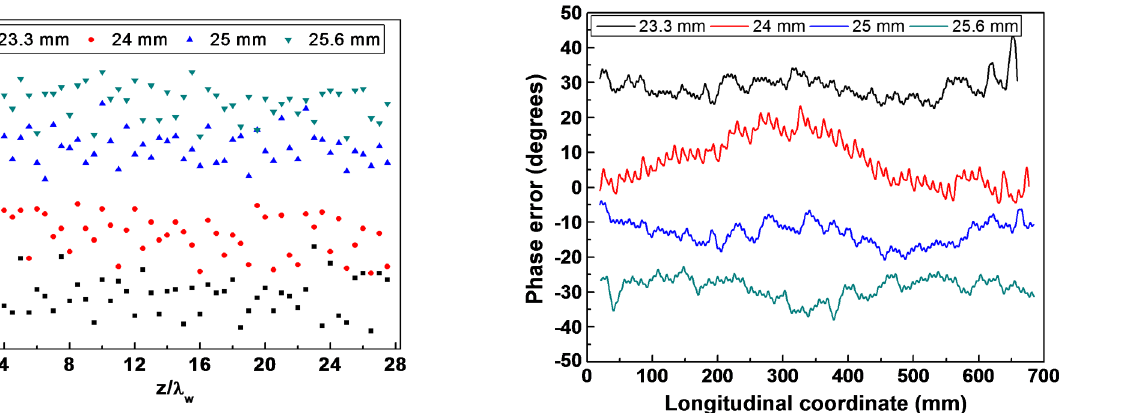
FIG. 9. Phase errors for periods 23.3, 24, 25, and 25.6 mm (top to bottom).